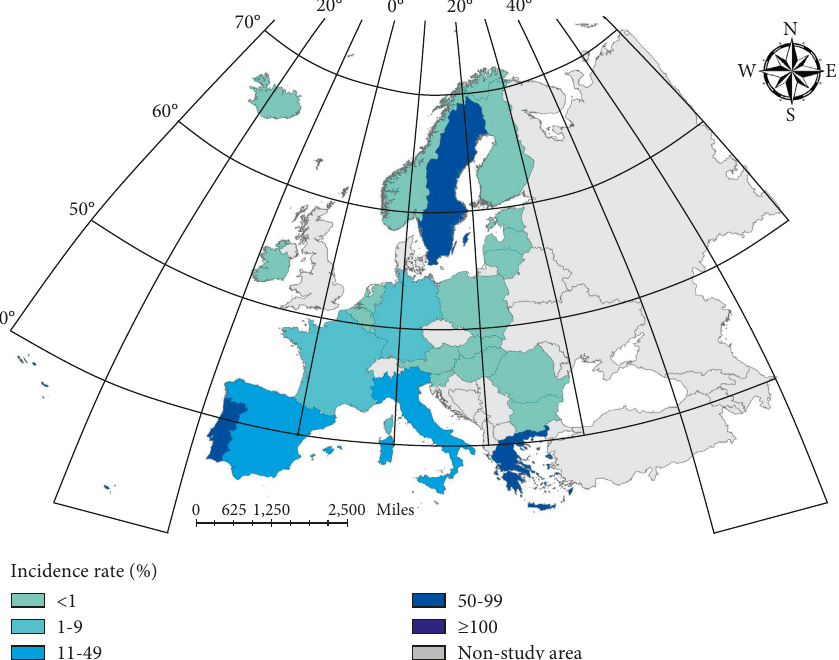
Figure 8: True value distribution of Brucella cases.